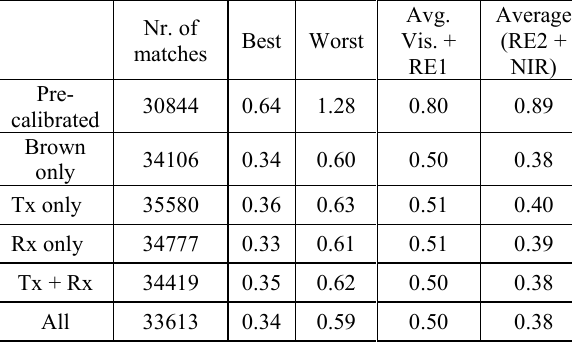
Table 5 . Orthophoto co-registration residuals, expressed in pixel, for the different calibration strategies (in